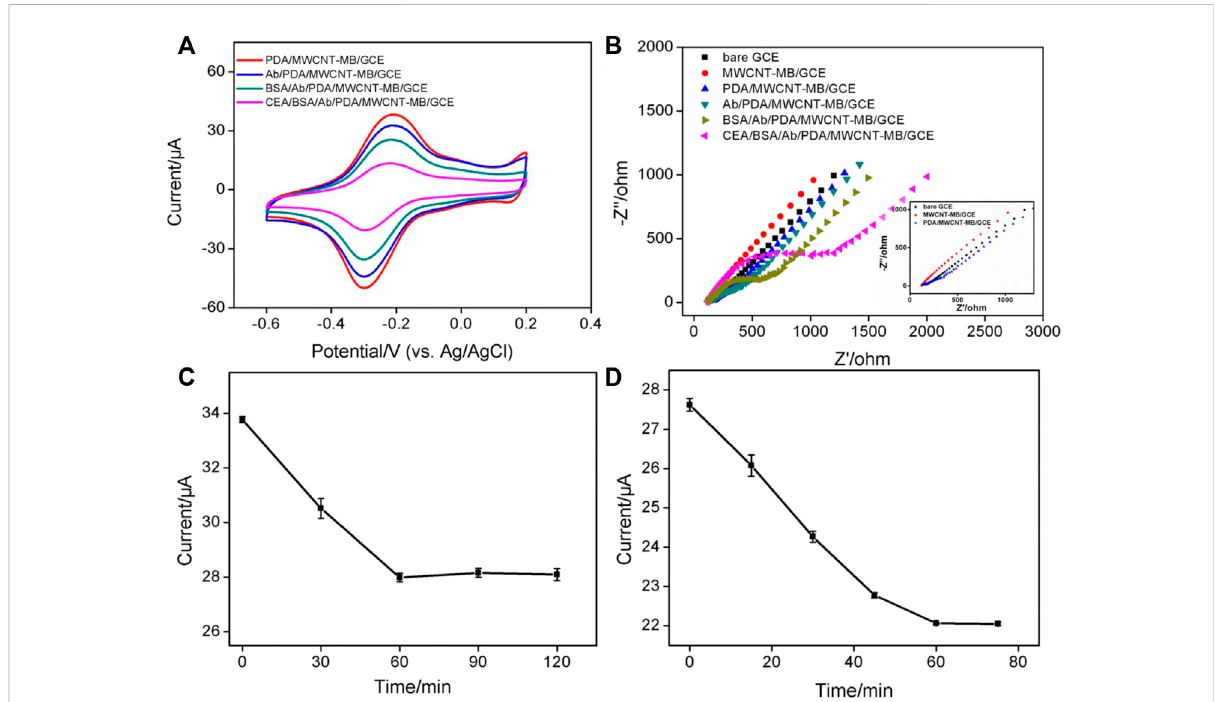
FIGURE 5 (A) CV obtained on different electrodes. (B) Nyquist plots obtained in KCl (0.1 M) containing Fe(CN) 6 3/4 − (2.5 mM). Inset is the magni fi edNyquist plots, respectively. (C) The peak current obtained after CEA binding on different immunosensors fabricated using different reaction time between PDA and Ab. (D) The peak current obtained after CEA binding using different incubation time between CEA and Ab. The concentration of Ab for the fabrication of the immunosensor is 100 μ g/ml. The used concentration of CEA is 1